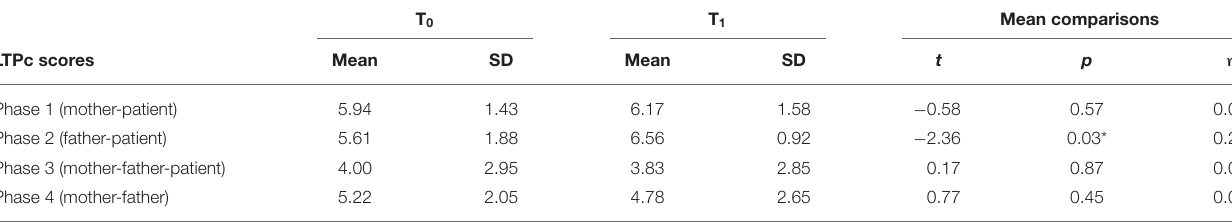
TABLE 2 | Descriptive statistics for the LTPc phases and mean comparisons. T 0 T